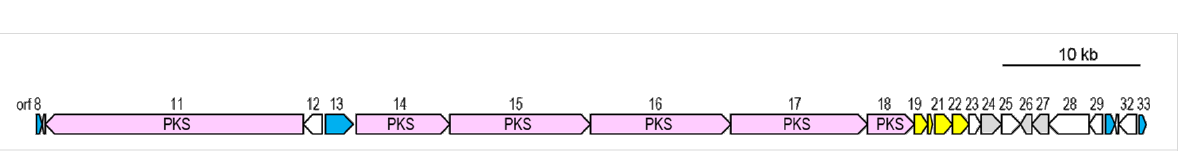
Figure 4: Feeding experiments of 13 C-labeled precursors into 1 detected by 2D-INADEQUATE NMR experiments. (a) [1,2- 13 C 2 ]acetate; (b) [U- 13 C 6 ]glucose.